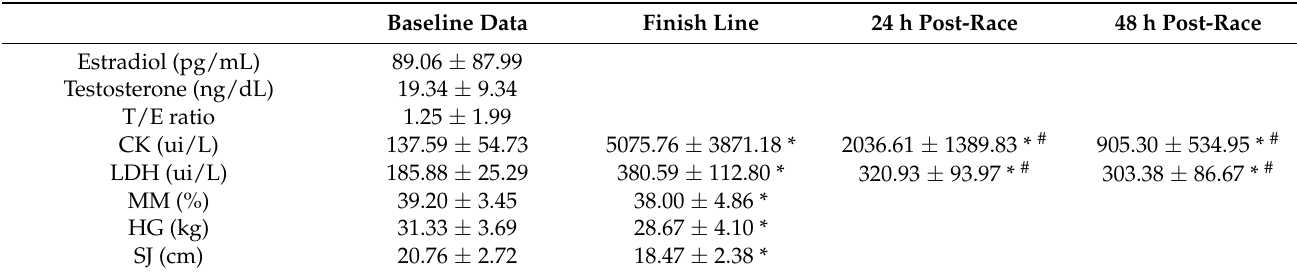
Abbreviations: T/E ratio: testosterone/estradiol ratio; CK: creatine kinase; LDH: lactate dehydrogenase; MM: muscle mass; HG: hand grip; SJ: squat jump. * Significantly different from the preceding time point ( p < 0.05); # significantly different from the pre-race value ( p <